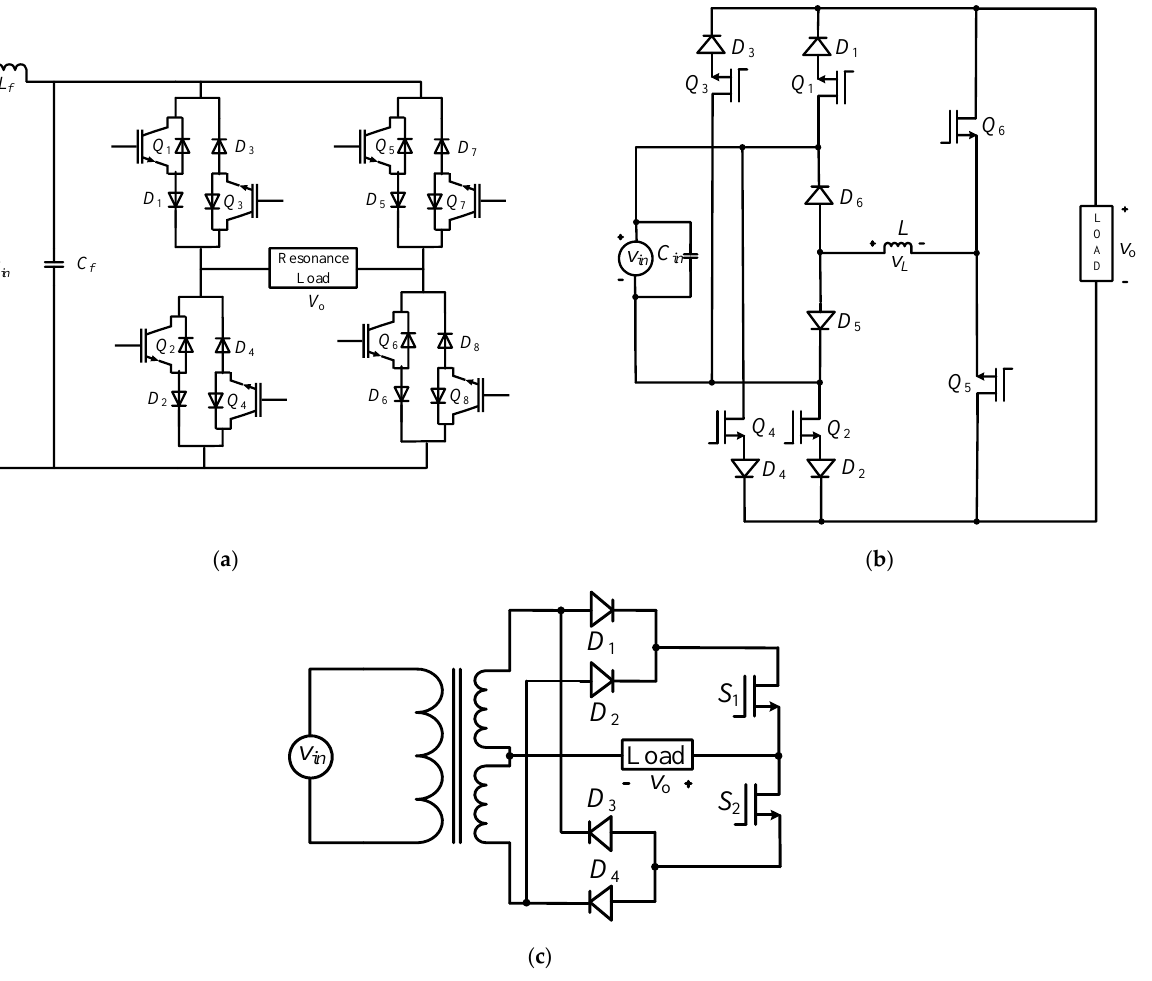
Figure 1. Various frequency converters without voltage adjustment control: ( a ) dual bridge approach; ( b ) transformer-less approach; ( c ) transformer-based approach.